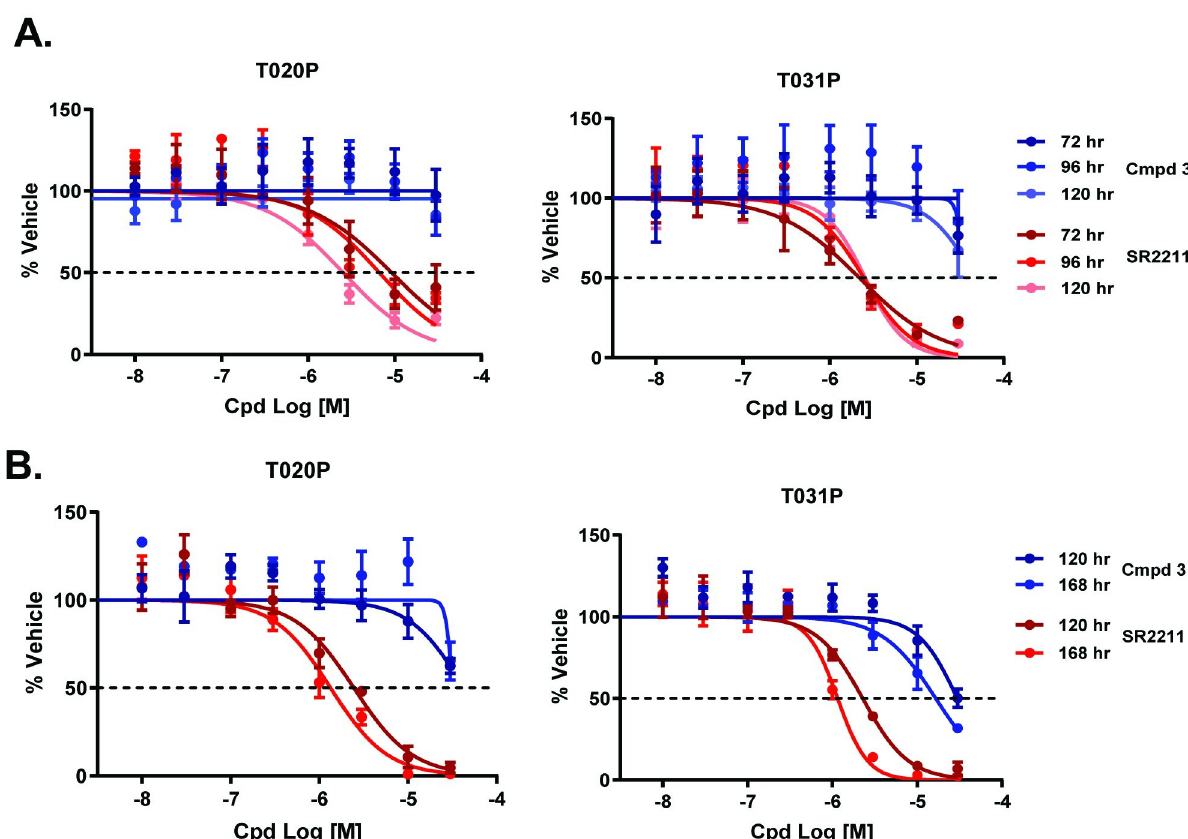
Fig 8. In vitro ROR γ t inhibitor activity on PDO growth & formation. PDOs T020P and T031P organoids were dissociated and treated with Compound 3 or SR2211 and either organoid growth or organoid formation defects examined. (A) Organoid growth assays, PDOs were treated with Compound 3 (red line) or SR2211 (blue line) beginning on day 3 after plating for the duration and dose indicated. All values were calculated as % relative to vehicle treated organoids in 3 replicate experiments. (B) Organoid formation assays, PDOs were treated with Compound 3 (red line) or SR2211 (blue line) starting on day 1 after plating for the duration and dose indicated. All values were calculated as % of vehicle treated organoids in 3 replicate experiments.